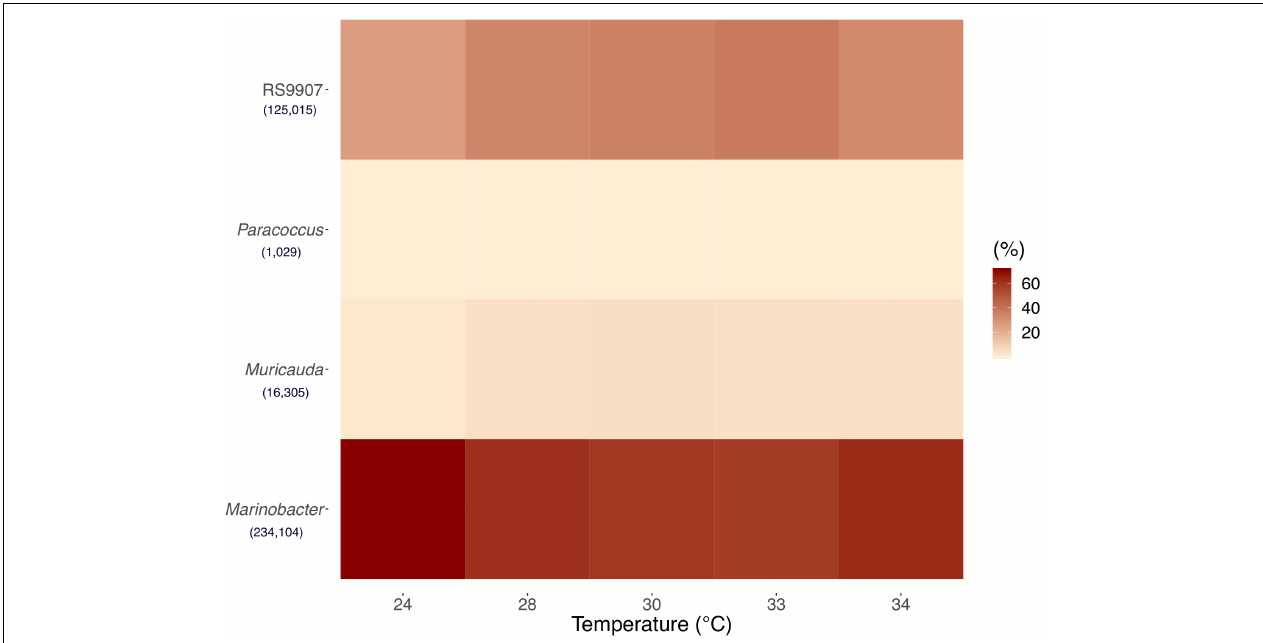
FIGURE 1 | Mean of triplicates 16S rRNA gene-based relative abundances of Synechococcus and the top three most abundant heterotrophic bacteria OTUs at the five incubation temperatures of Experiment C after 48 h. See the text for details. Numbers in brackets represent total OTUs